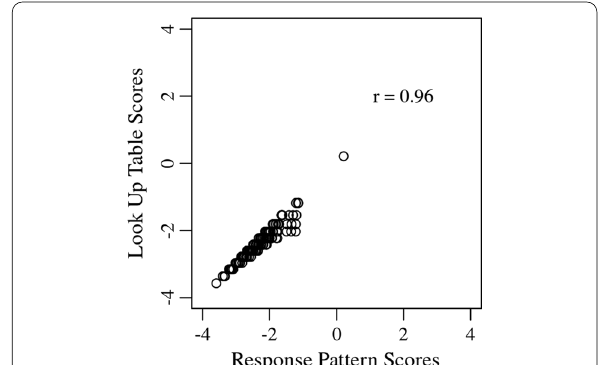
Fig. 10 Comparison of look-up and pattern response Expected A Posteriori scoring methods